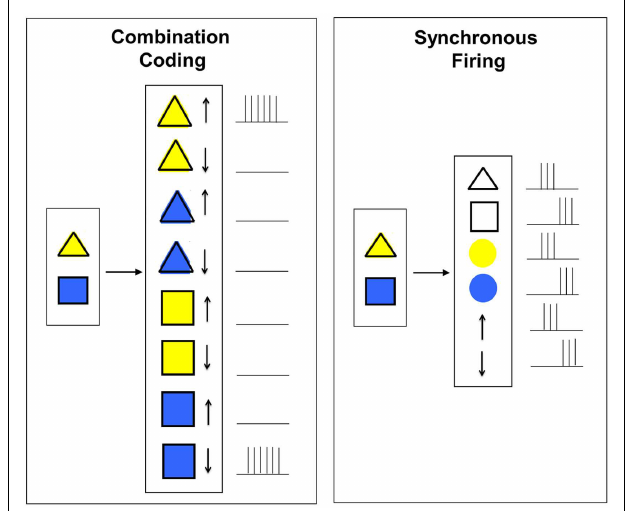
FIGURE 2 | Combination coding vs. binding by synchronous firing.